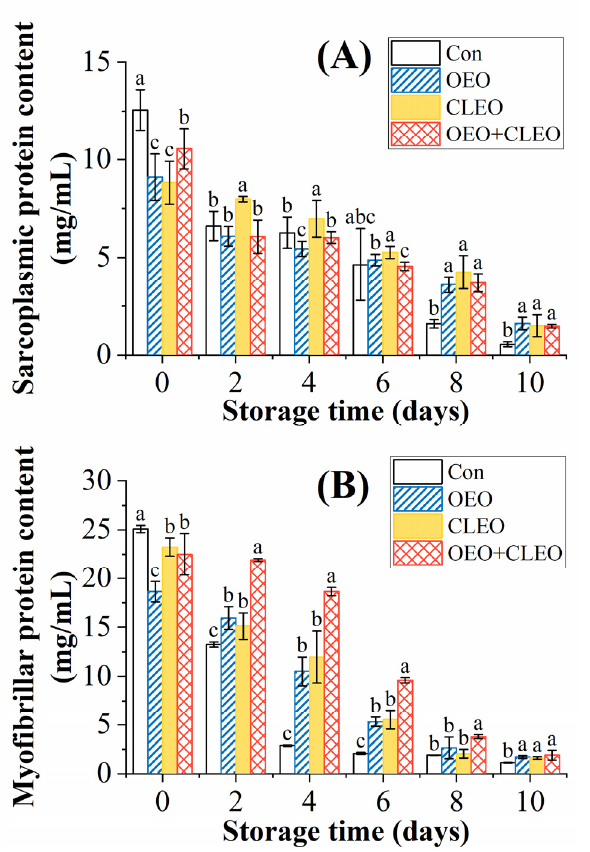
Figure 2. Changes of the content of sarcoplasmic protein ( A ) and myofibrillar protein ( B ) of refrigerated Pacific white shrimp treated with OEO and CLEO at 4 °C. Data are shown as mean ± SD (n = 3). Note: Different lowercase letters indicate significant differences ( p < 0.05) among different treatments within the same storage time.